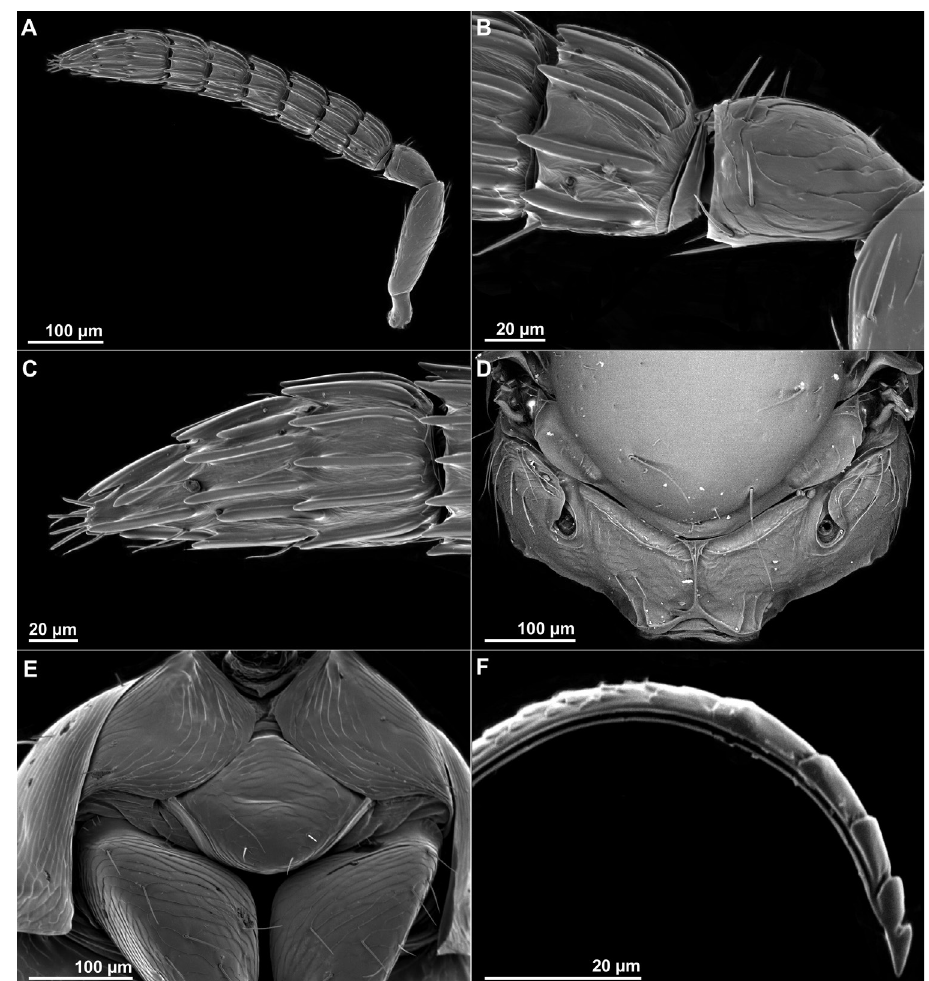
Figure 5. Sycobia hodites Farache & Rasplus, sp. n. Female, sem. A Antenna B Close-up of the pedicel, anellus and f1 C Clava D Propodeum in dorsal view E Prosternum F Ovipositor. elongated, larger than in females. Distance from torulus to oral margin 0.6× distance from torulus to median ocellus. Ocelli well developed. POL 1.0–1.1× OOL. Funicular segments transverse, less than 0.5× as long as wide. Pronotum elongated, nearly 0.5× as long as wide in dorsal view. Propodeum without a median longitudinal crest or fur- rows. Wings slightly